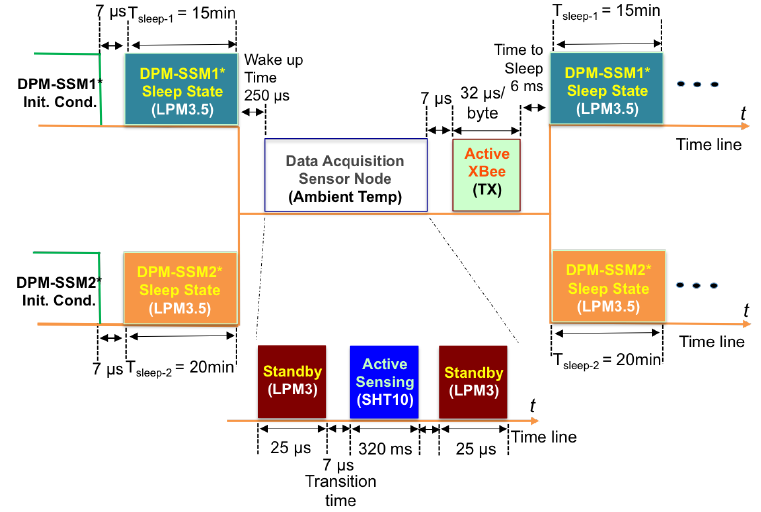
Figure 5. Dynamic Power Management Strategy for Ultra-Low Power